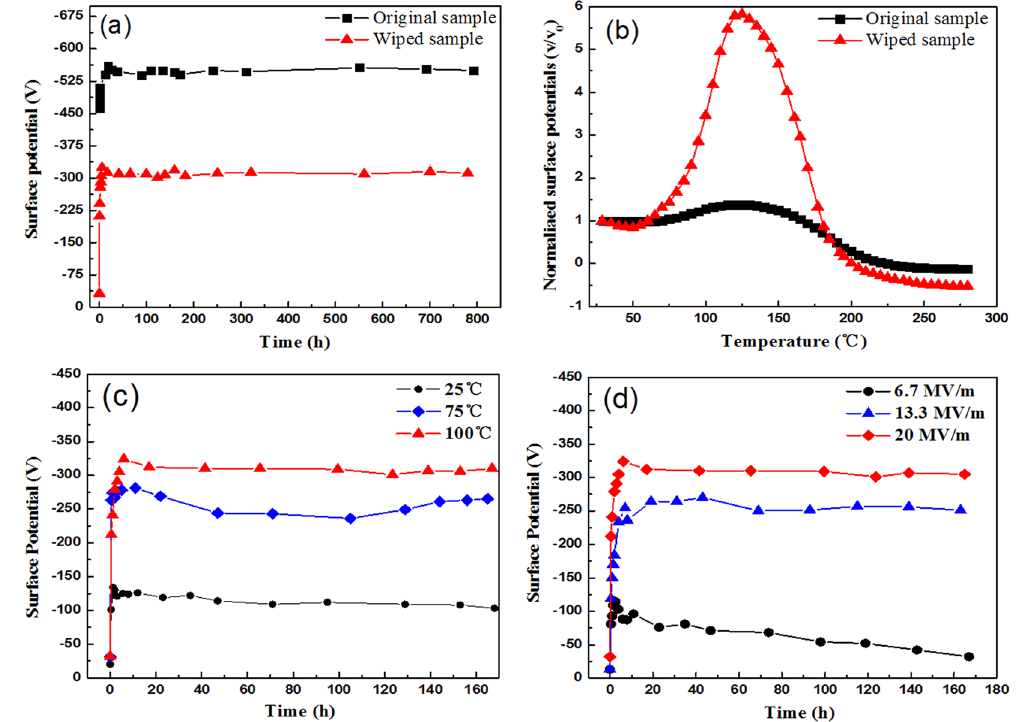
Figure 1. Persistent electrostatic performance of flexible electret membrane. ( a ) V s of the original and wiped sample as a function of storage time. ( b ) Normalized V s of the original and wiped sample as a function of temperature. ( c ) V s as a function of storage time for the wiped sample charged at different T p . ( d ) V s as a function of storage time for the wiped sample charged at different E P